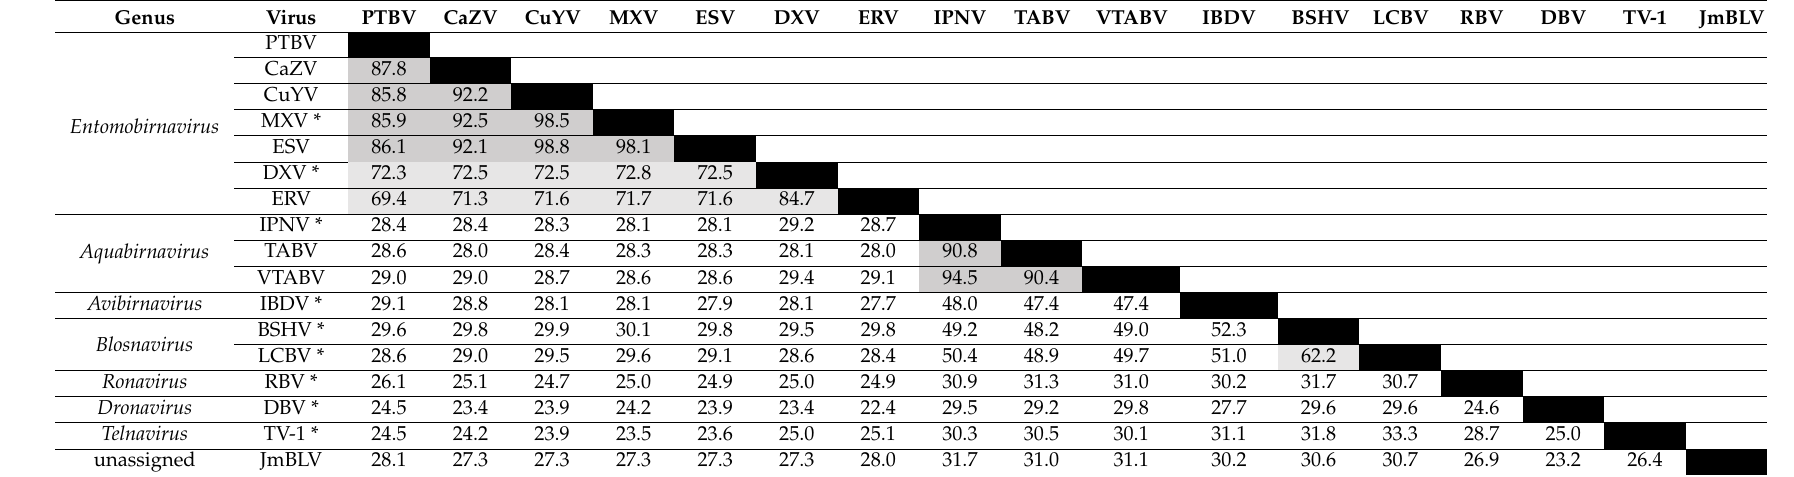
Table 1. Percentage amino acid sequence identities (p-distance) of a ClustalW alignment of birnavirus VP1 (RdRp) proteins.